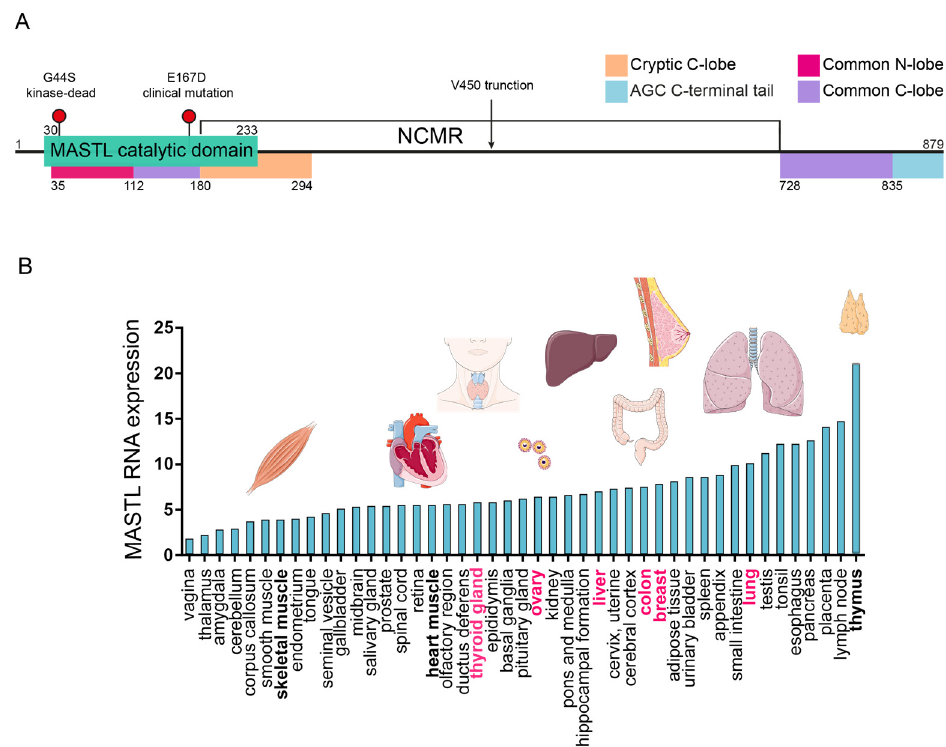
Figure 1. Microtubule-associated serine / threonine kinase-like MASTL structure and expression in normal tissue and cancer. ( A ) Schematic of the human MASTL gene showing the catalytic domain (green), along with the sites of kinase-inactivating (G44S) and clinically relevant (E167D) mutations. In line with Hermida, D. et al. (2020), the common C- and N-terminal lobes (purple / pink), cryptic C-lobe (orange), AGC N-terminal tail (blue), and the non-conserved middle region (NCMR) (white) are annotated. The site of the V450 cancer-relevant truncation is also indicated. For further structural details, please refer to [5]. ( B ) MASTL RNA expression in normal tissue [6] (URL: http: // www.proteinatlas.org). The organs written with bold text are provided as illustrations (illustrations provided by Servier Medical Art under a Creative Commons license, URL: https: // smart.servier.com). The organs (thyroid gland, ovary, liver, colon, breast, and lung) written in pink text are where high MASTL expression has been shown to correlate with poor cancer prognosis (or where MASTL has been associated with cancer).